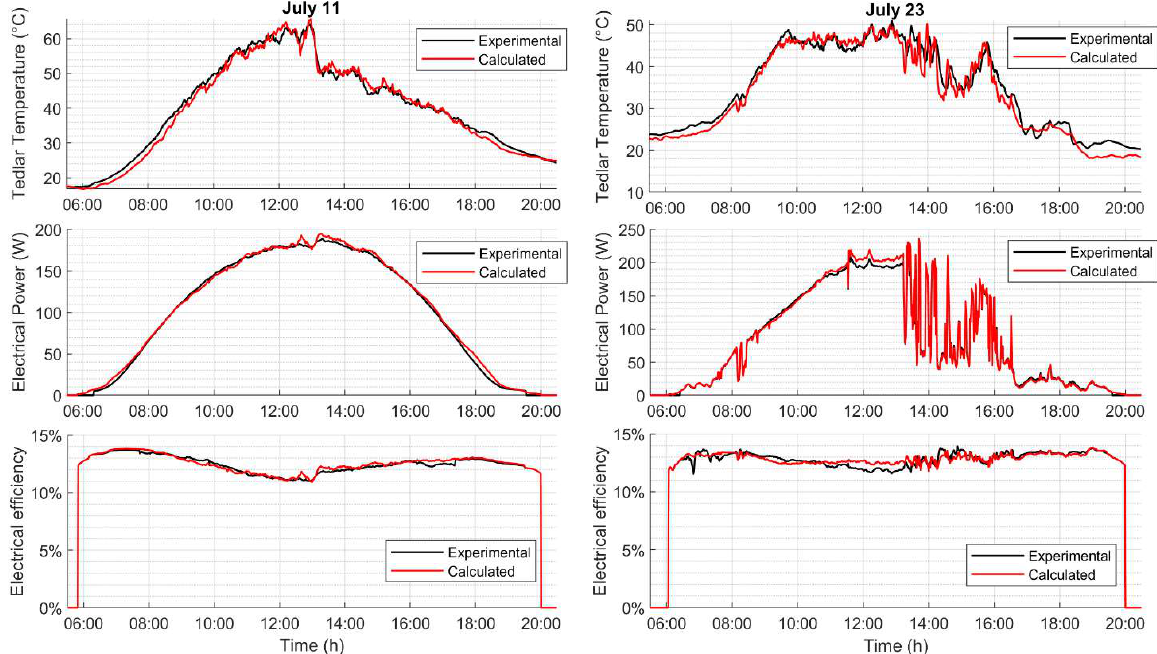
Figure 10. Tedlar Temperature, Electrical Power and Efficiency for a clear day and overcast day.